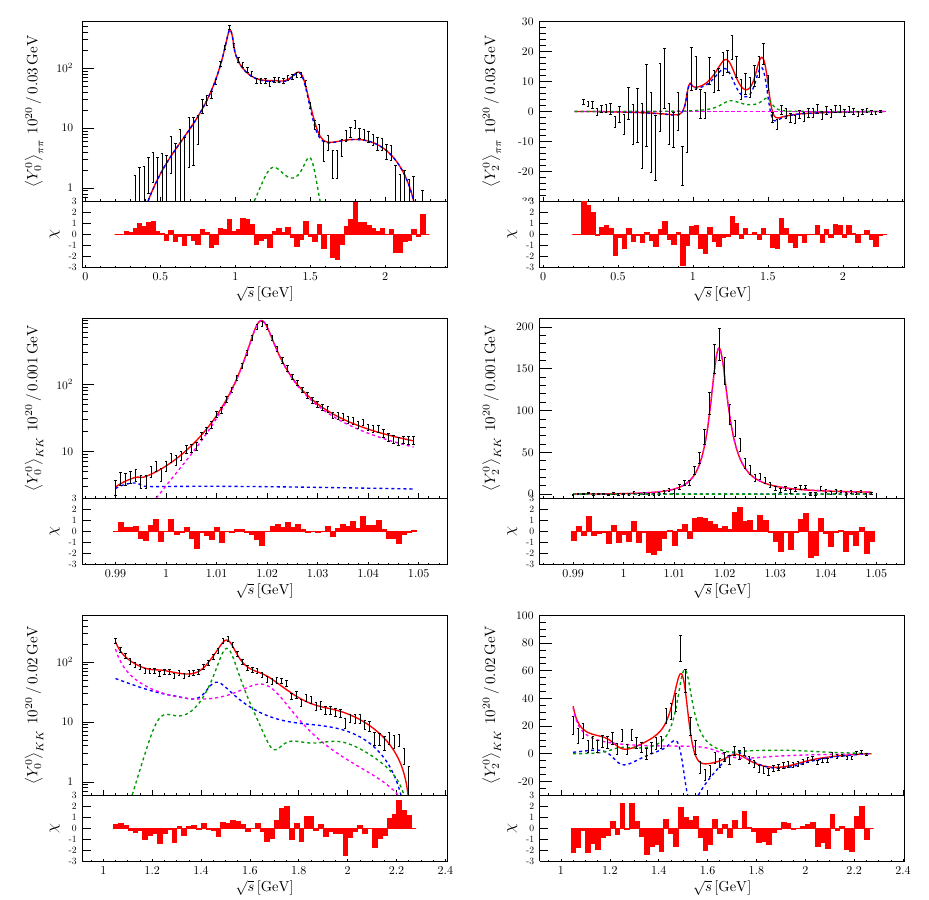
(cid:68) (cid:69) (cid:68) (cid:69) → J /ψπ + π − [18] (top Y 0 Y 0 (left) and (right) of ¯ B 0 s 0 2 = 2 with a constant polynomial and an additional R (cid:16)(cid:68) (cid:69) (cid:68) (cid:69) (cid:17) − Y 0 Y 0 /σ measured L L measured fit